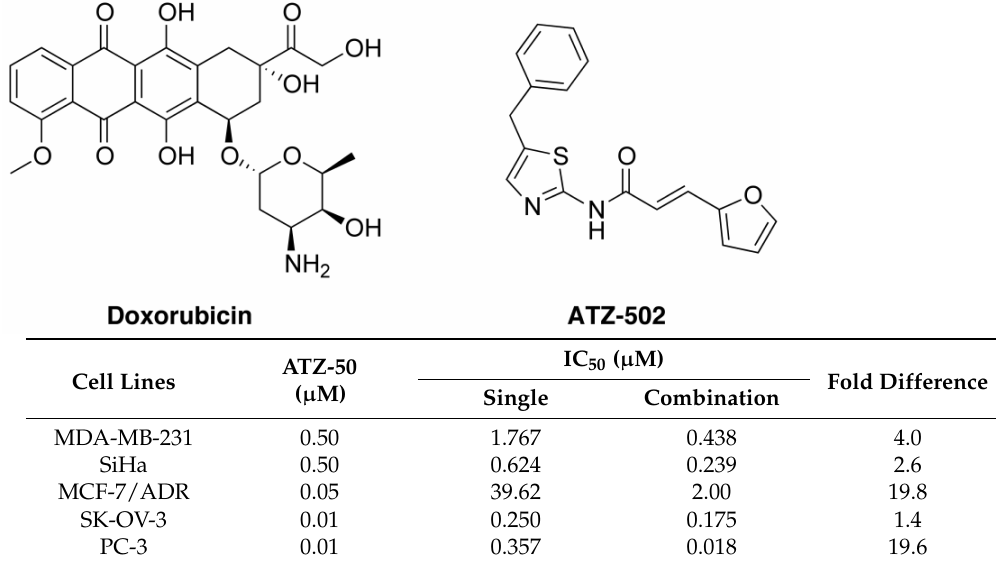
Table 1. IC 50 of single and combination treatment with doxorubicin and ATZ-502. ATZ-502 concen- tration was determined with IC 50 after cytotoxicity assay. Cell lines were treated with a range of doxorubicin concentrations as indicated to assess the combination effect with ATZ-502. Cell lines were exposed to drugs for 72 h. The Ez-Cytox reagent (20 µ L) was administered to each well, and the absorbance measurements were taken at 450 nm. All values are averages of replicates expressed relative to the cell viability values in the untreated cells normalized to 100%. Cytotoxicity represents four replicates per drug concentration for each